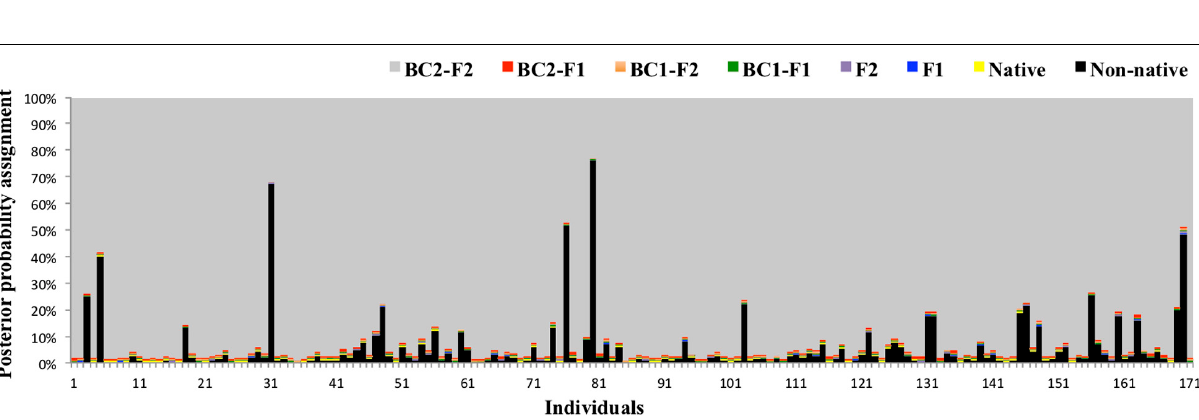
Frontiers in Ecology and Evolution |